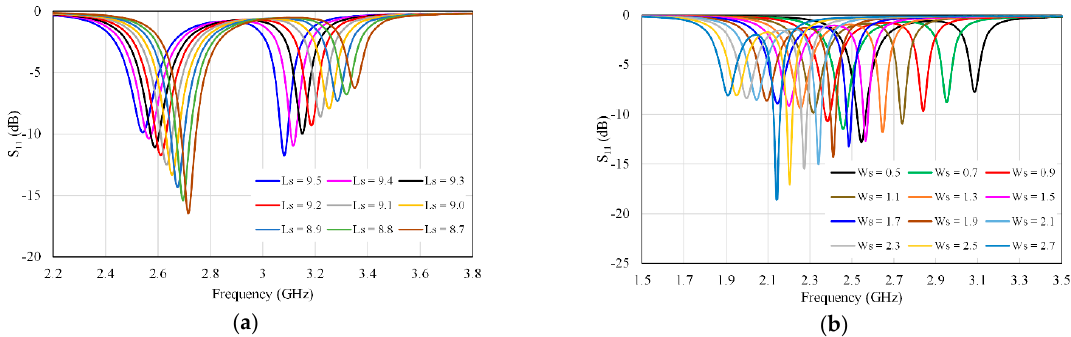
Figure 10. Frequency responses of slotted square patch antenna (dual-band) ( a ) for different Ls values, with Ws = 0.2 mm, and ( b ) for different Ws values, with Ls = 8.5 mm.